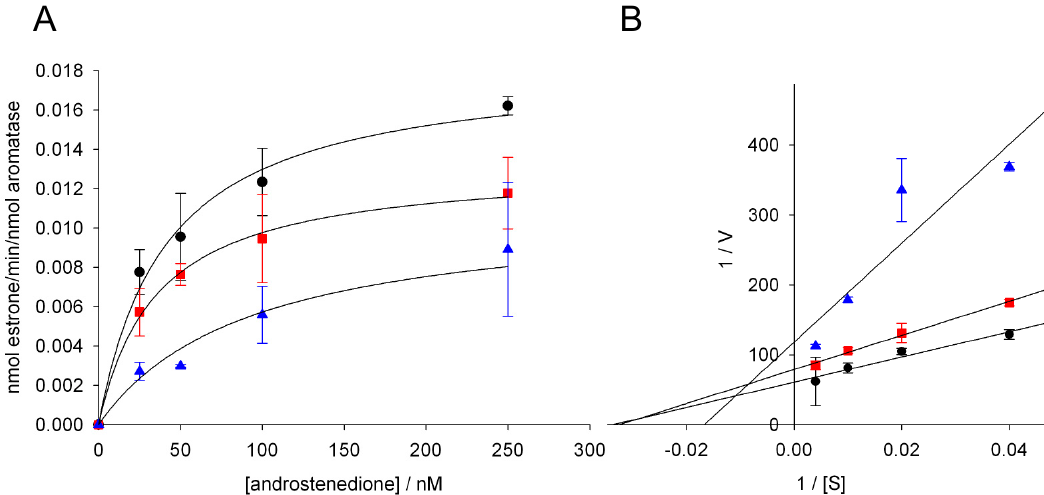
Figure 2. ( A ) Michaelis-Menten plots and ( B ) Lineweaver-Burk linearization for aromatase activity in the absence (black circles) and presence of 1000 nM (red squares) and 5000 nM (blue triangles) of glyphosate. In Panel ( A ), the data were fitted to the Michaelis-Menten equation using the Sigma Plot software to obtain the kinetic parameters.